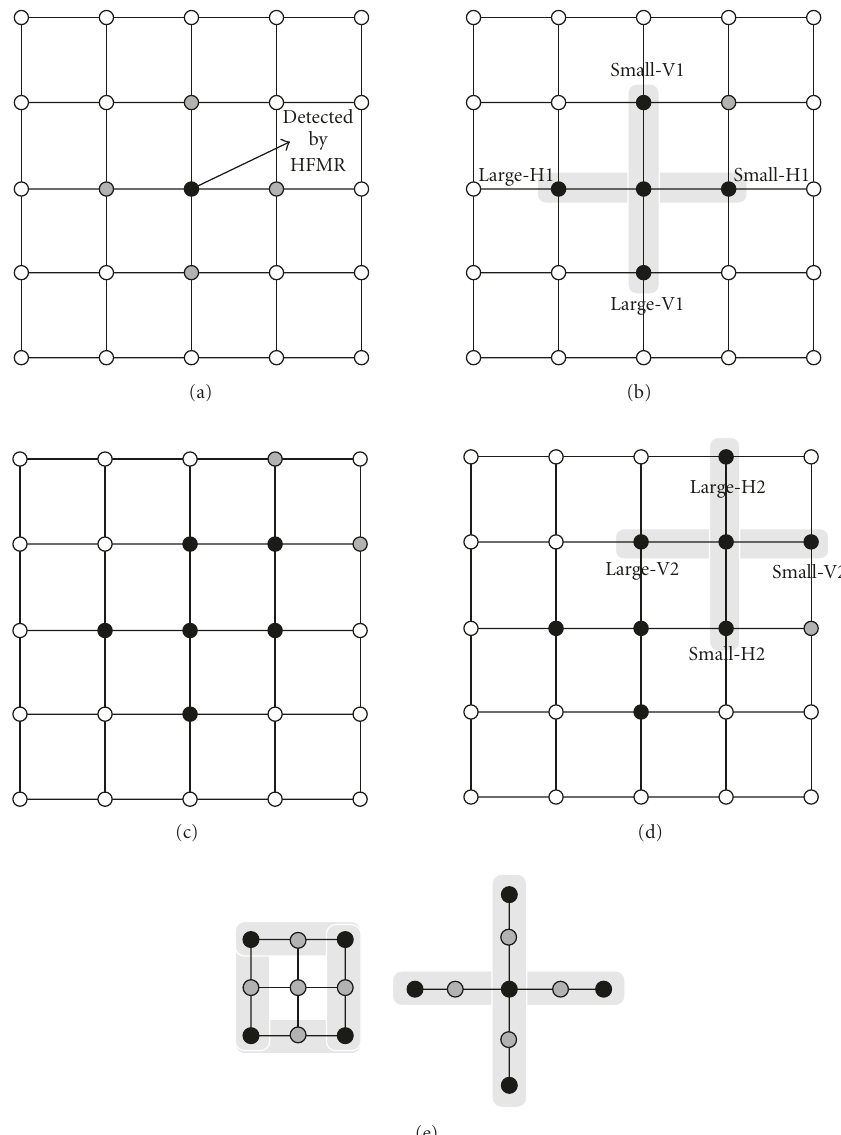
Figure 15: Steps in double cross-search algorithm: (a) Step 1, (b) Step 2, (c) Step 3, (d) Step 4, (e) Step 5 of double cross-search algorithm.